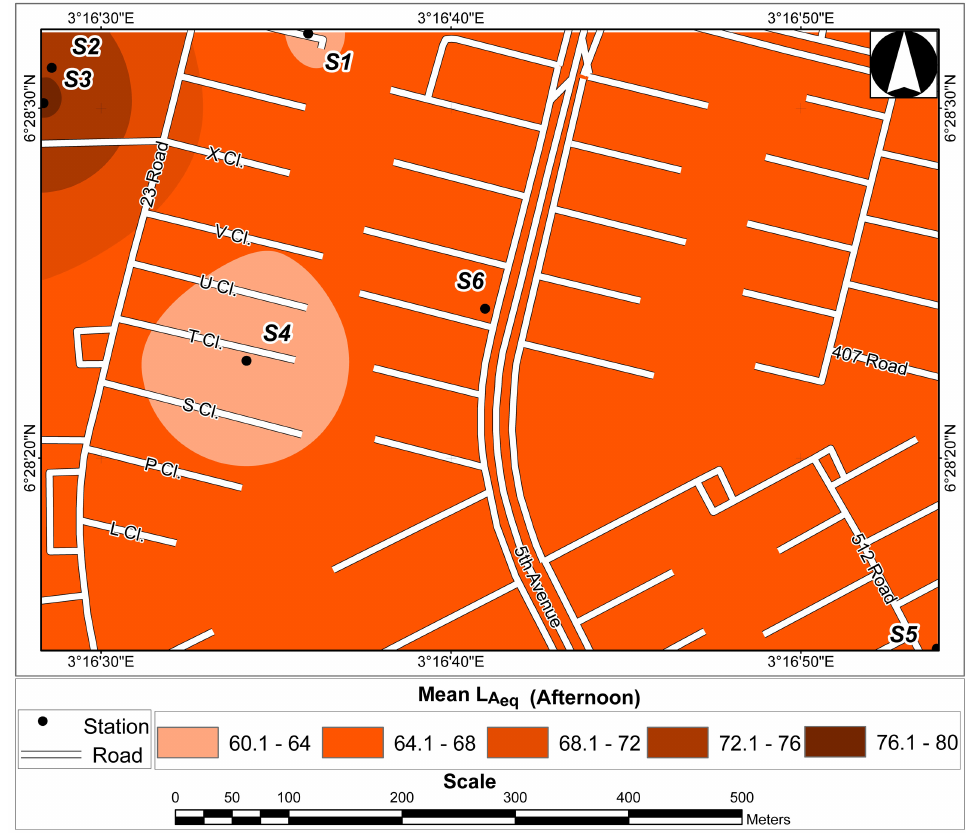
Figure 6: Mean L Aeq for the afternoon period derived by kriging interpolation Table 4: Descriptive statistics of L Aeq noise levels –